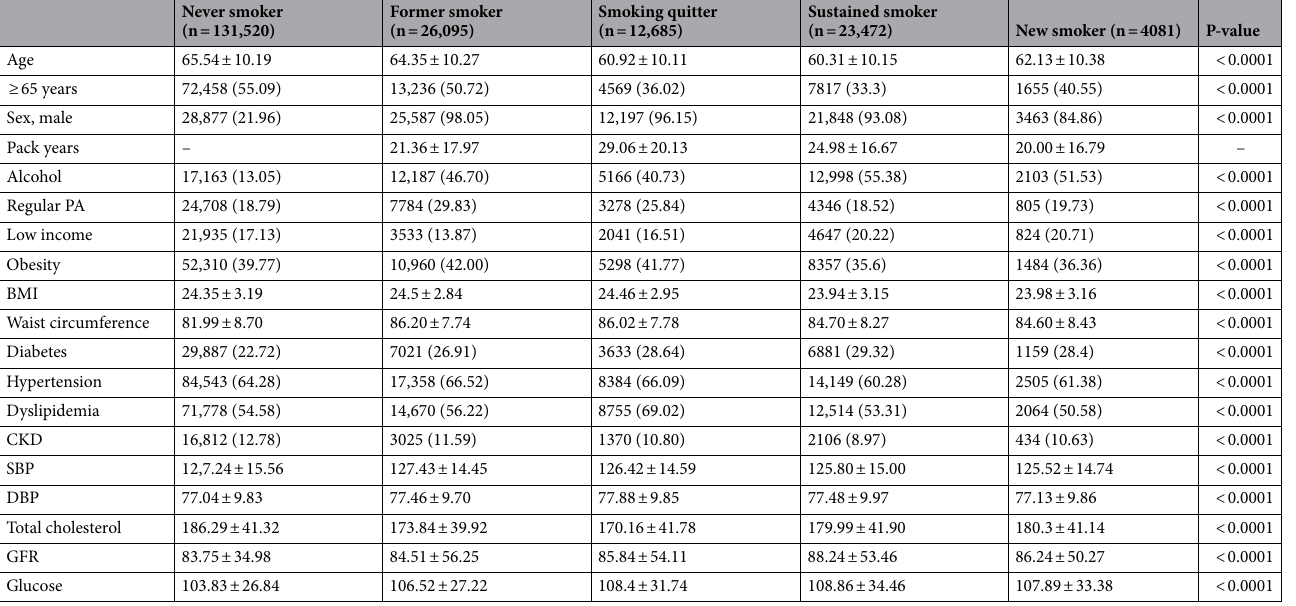
Table 1. Demographic and Clinical characteristics according to the smoking habit change in patients with ischemic stroke. PA physical activity, BMI body mass index, CKD chronic kidney disease, SBP systolic blood pressure, DBP diastolic blood pressure, GFR glomerular filtration rate.